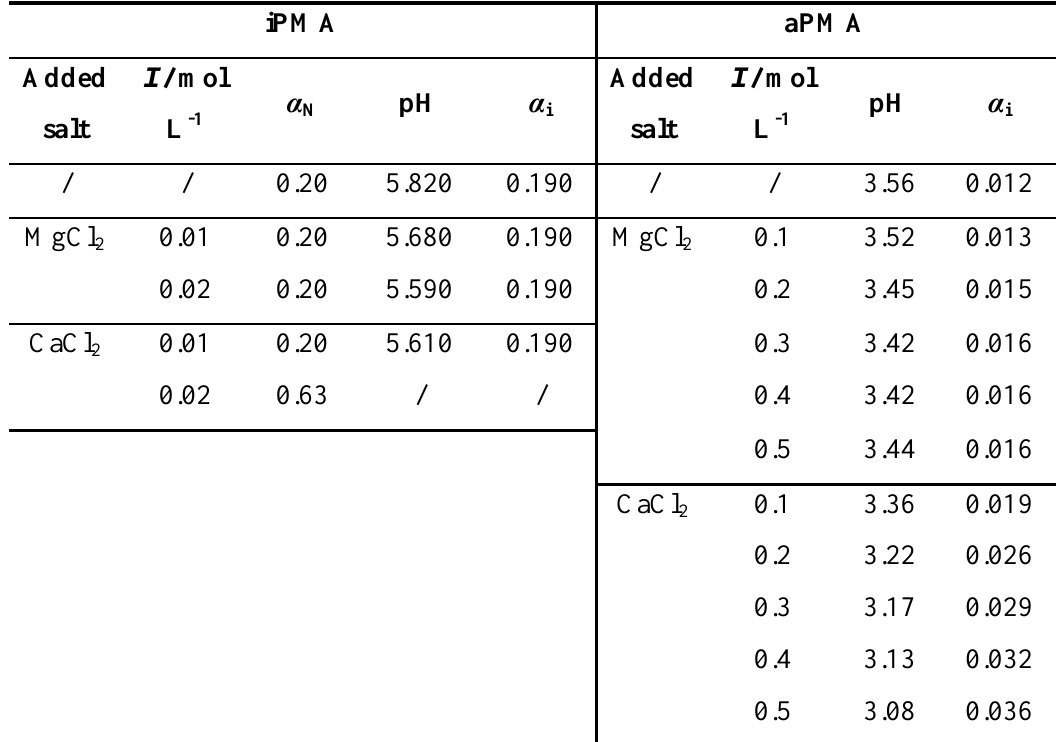
= 0.022 mol L -1 , α = 0.20) and aPMA ( c p N